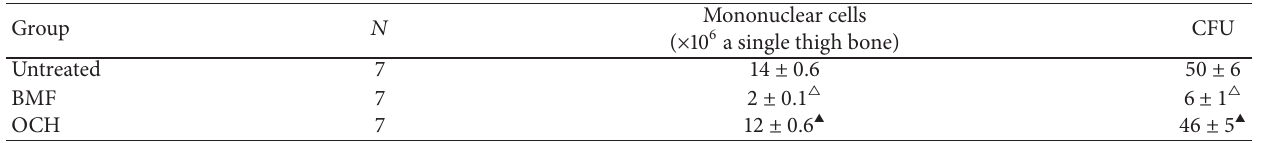
Table 7: The numbers of mononuclear cells and